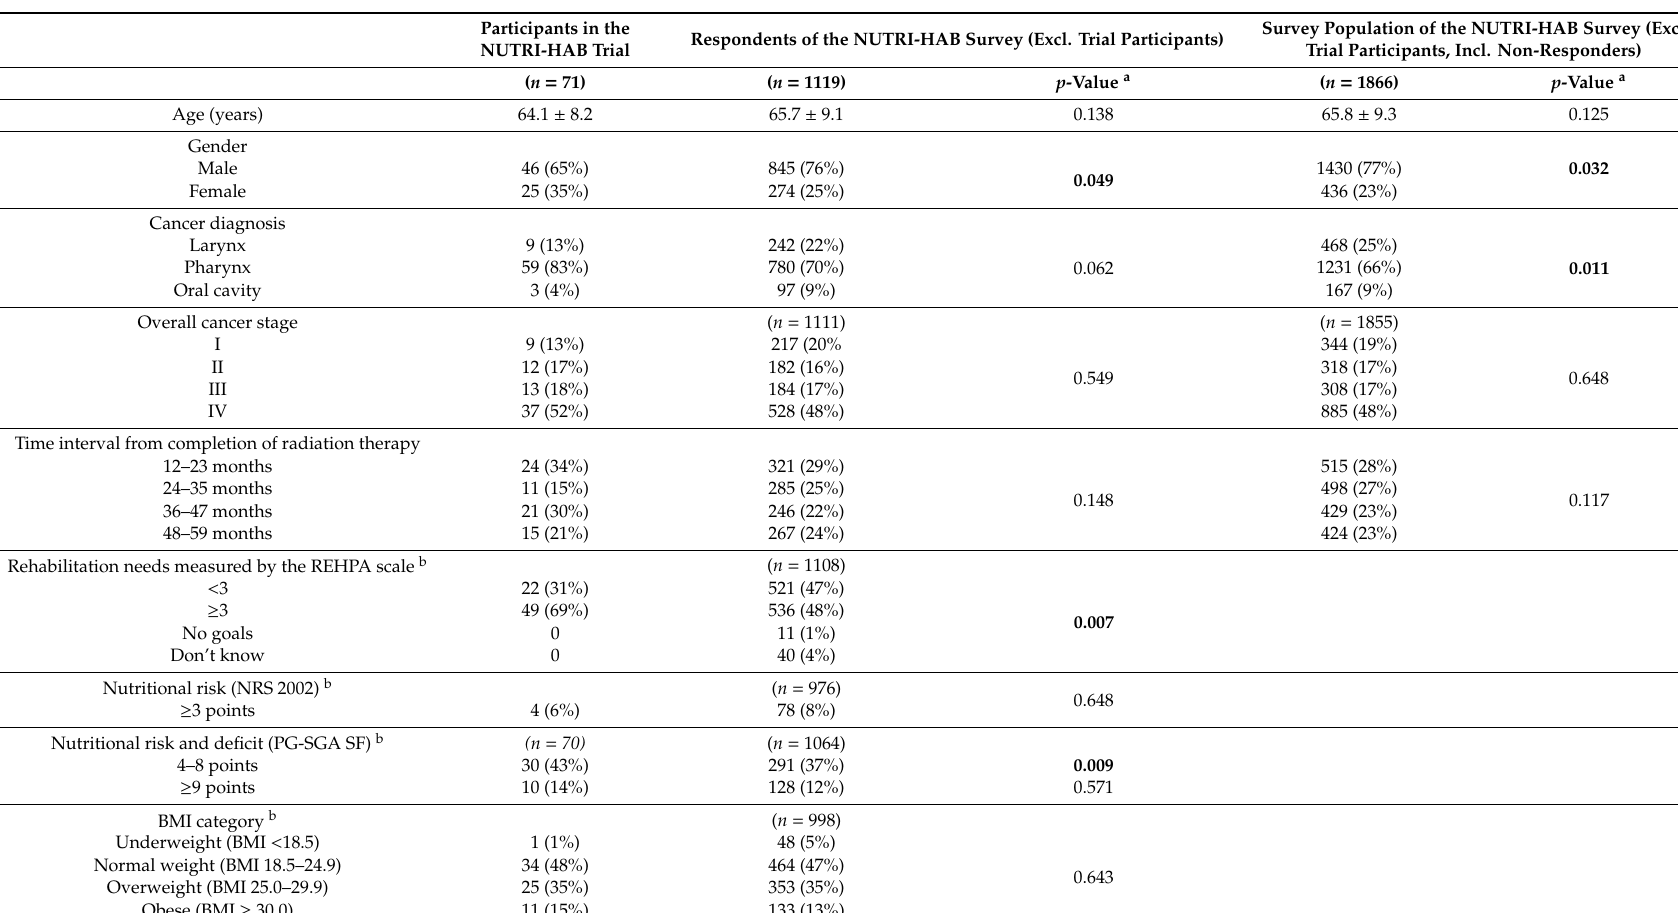
Table A4. Characteristics and di ff erences between participants in the NUTRI-HAB trial and the NUTRI-HAB survey population. Participants in the NUTRI-HAB